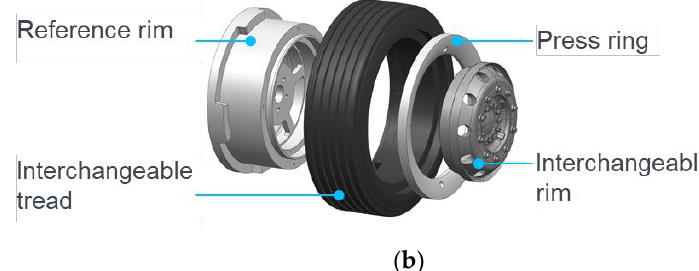
Figure 2. Front wheel of the vehicle model: ( a ) Manufactured wheel; ( b ) Assembly sketch showing the different components of the wheel.